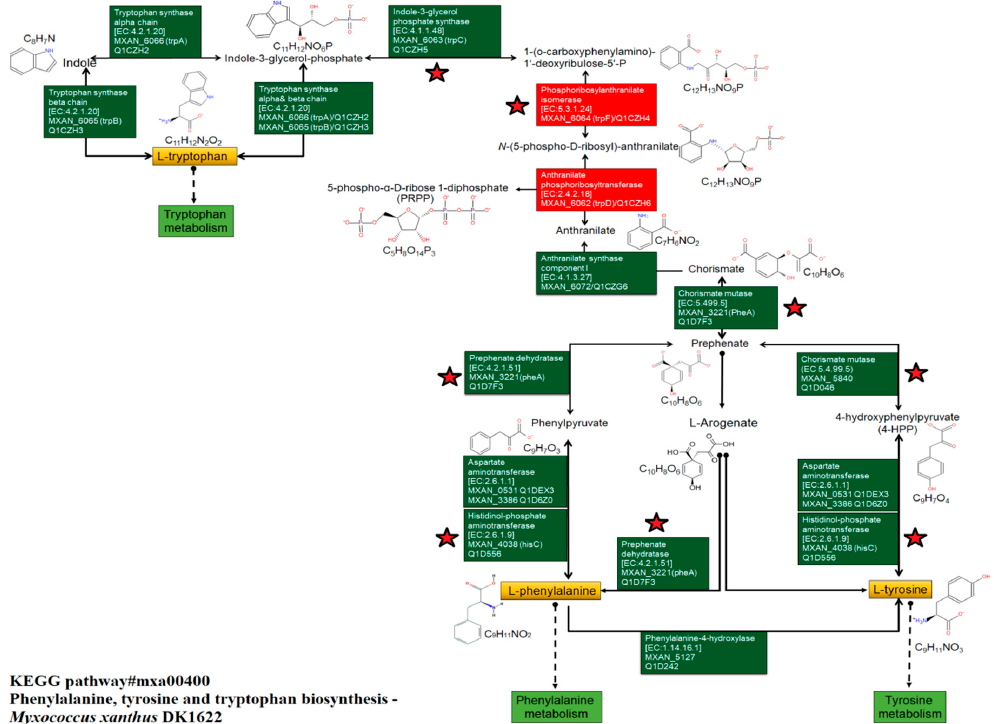
Figure 7. Phenylalanine, tyrosine, and tryptophan biosynthesis, KEGG Pathway ID: #mxa00400. When the boundary formed, the three aromatic amino acids, L -penylalanine, L -tyrosine, and L -tryptophan, biosynthesis also appeared. Chorismate is the common intermediary in the formation of all three aromatic amino acids. Green boxes represent the enzymes present when the boundary appeared, while red boxes represent enzymes missing in the boundary samples (Table S7) The red stars represent the enzymes missing in the non-boundary samples (DK166-DK1622). Pathway analysis was performed by using KOBAS v3.0 (KEGG Orthology Based Annotation System).